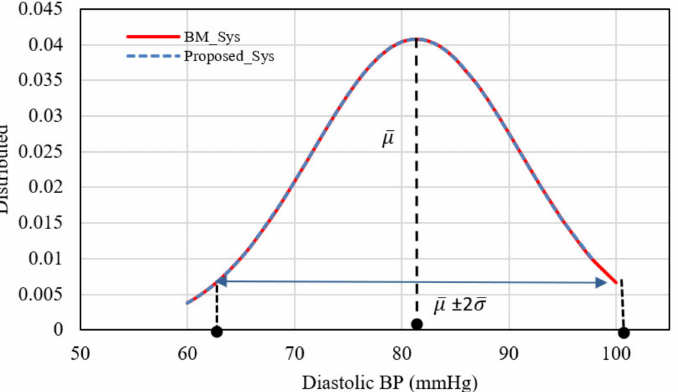
Figure 12. The PDF test of the diastolic BP measurements against their corresponding benchmark measurements.